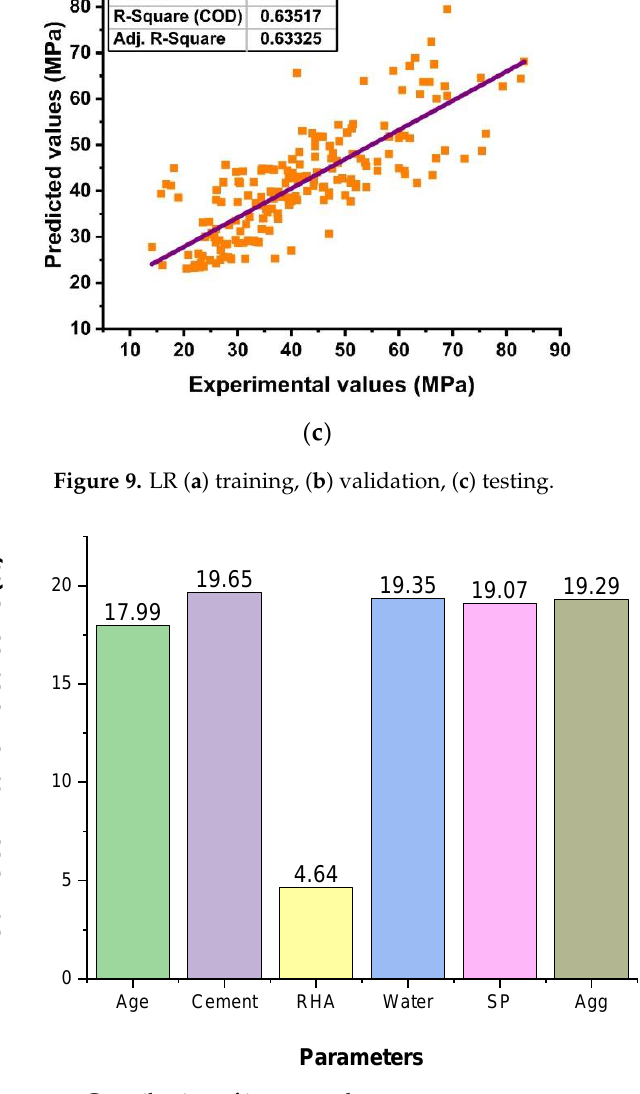
Figure 9. LR ( a ) training, ( b ) validation, ( c ) testing .